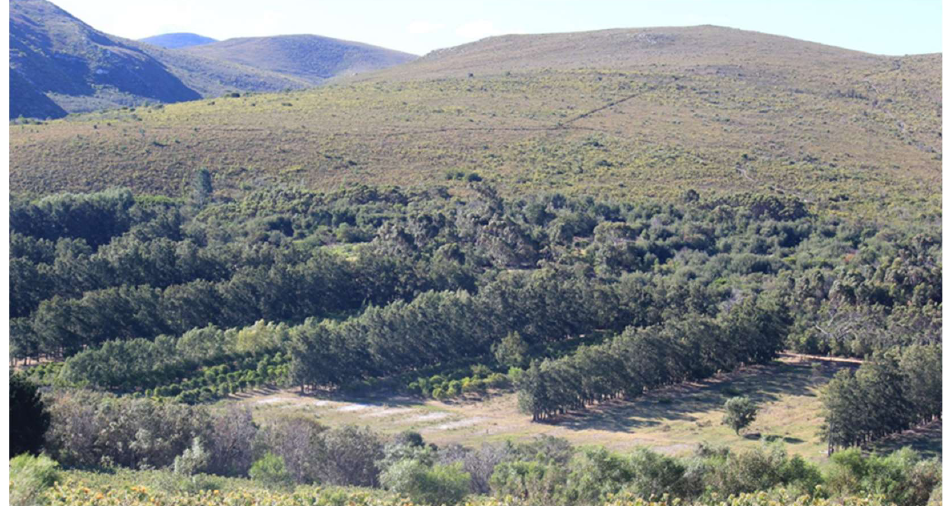
Figure 14. Impression of an agroforestry system in the dryland regions of Gansbaai, South Africa (Image credit: B. Winkler).